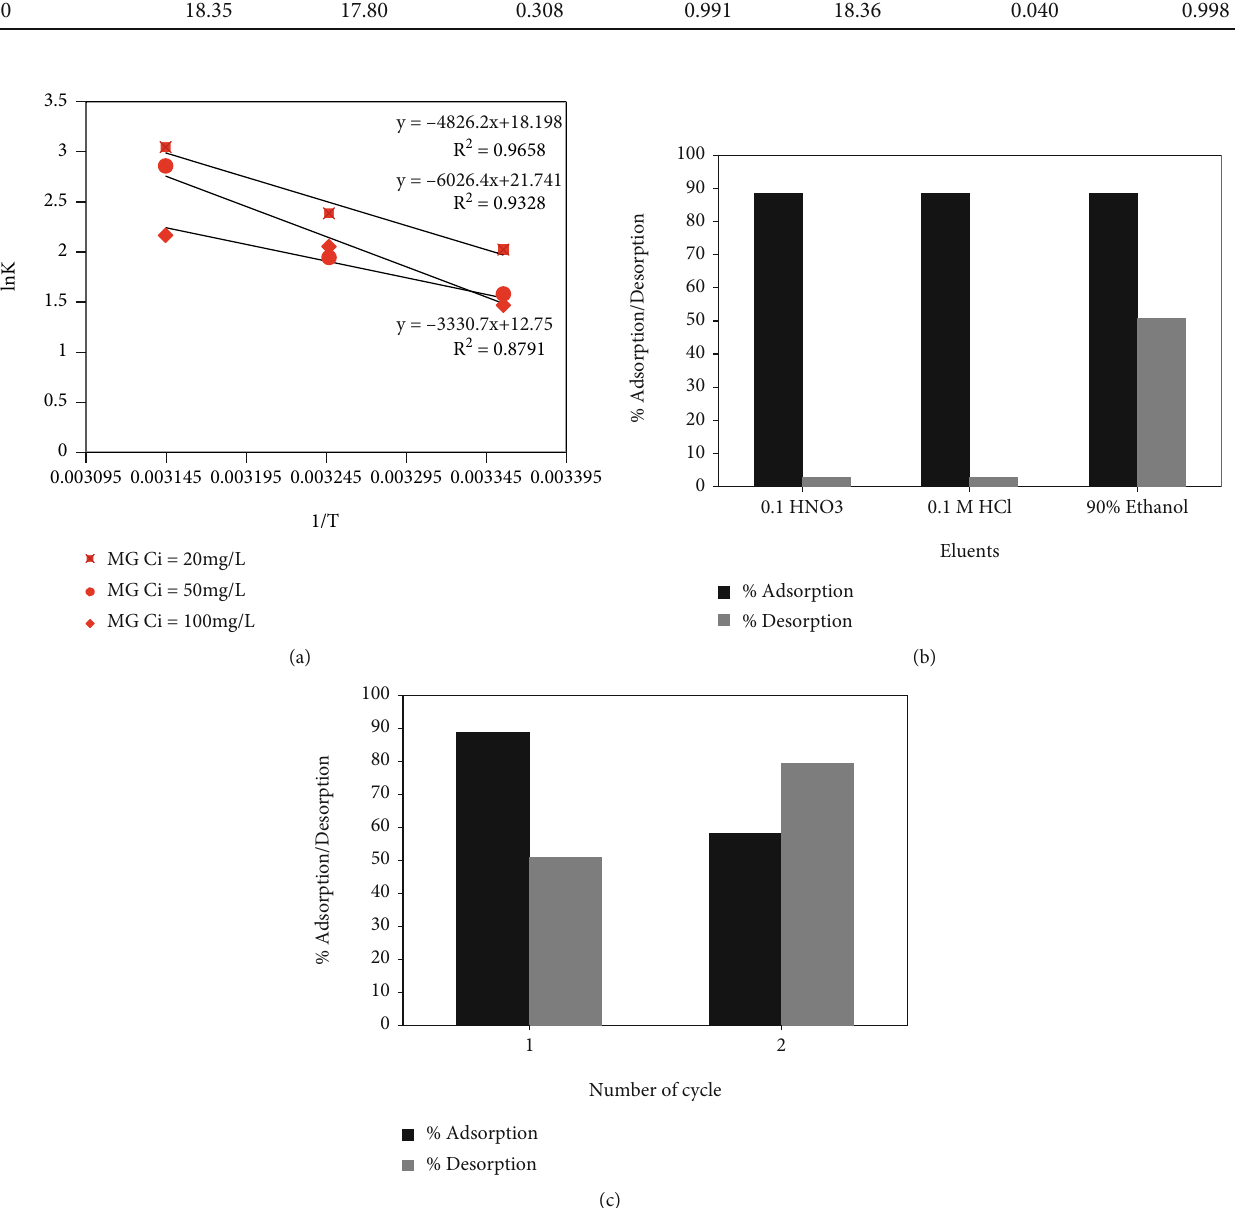
Figure 7: (a) Adsorption thermodynamics, (b) adsorption/desorption plot of MG dye from Fe (conditions: MG — 20 mg/L, time — 120min, Fe